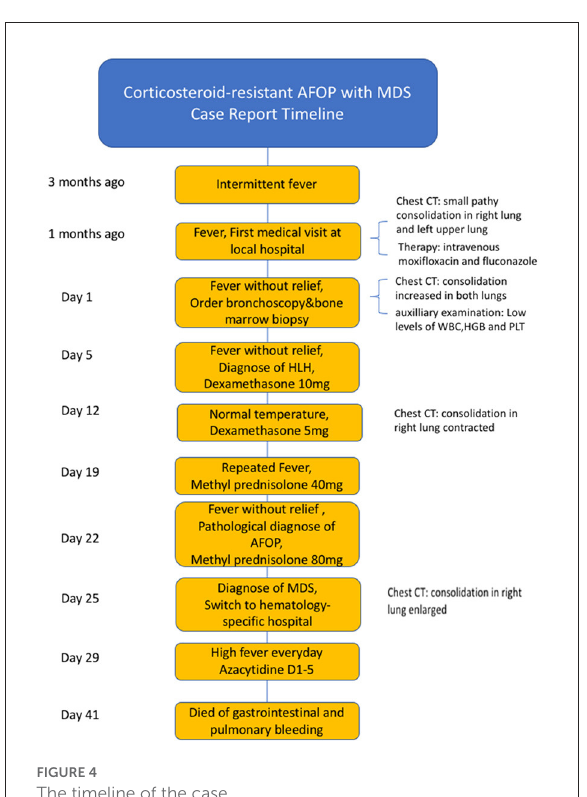
FIGURE4 The timeline of the